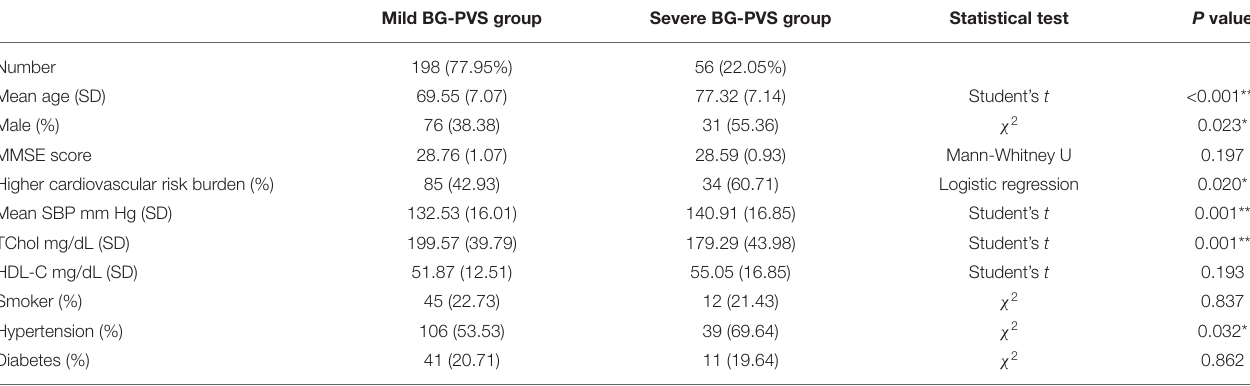
TABLE 2 | Comparison of cardiovascular risk factors in subjects with mild or severe